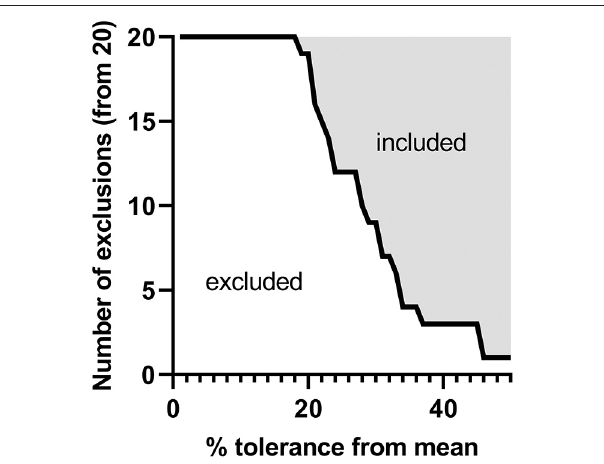
FIGURE 6 | Hypothetical tolerance criteria compared to the variance observed from the 20 peanut genotypes studied. For each of the 20 genotypes studied, the quantities of Ara h 1, 2, 3, and 6 obtained by shared peptide quantitation (percentage peanut protein [allergen (g)/total protein (g)] were compared to the overall mean per allergen family and screened as if they were clinical materials. Genotypes were separated into included or excluded groups per percentage tolerances from 0 to 50% given the relative difference of each of Ara h 1, 2, 3, and 6 to the overall mean per family as well as if any of these allergens were outside of a given tolerance